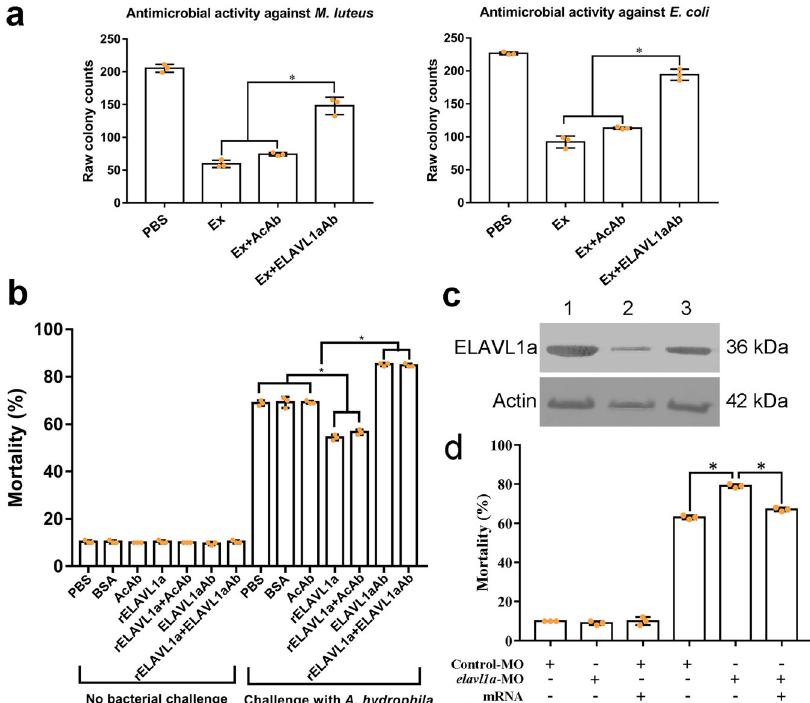
Fig. 6 Antibacterial activity of ELAVL1a in vitro and in vivo. a Antimicrobial activities of the embryo extract against M. luteus and E. coli . b The early (8-cell stage) embryos were fi rst microinjected with PBS, BSA, anti- β -actin antibody (AcAb), anti-ELAVL1a antibody (ELAVL1aAb), rELAVL1a, and rELAVL1a plus AcAb or rELAVL1a plus ELAVL1aAb and then challenged by injection with live A. hydrophila (8.3 × 10 7 cells/ml). The development of the embryos was observed, and the cumulative mortality rate was calculated at 24 h after bacterial injection. c Western blotting analysis of the ef fi cacy of elavl1a -MO. β - Actin was used as control. Lane 1, 2, 3, the levels of ELAVL1a and β -Actin in the embryos injected with control morpholino (1), elavl1a -MO (2), or co- injection of elavl1a -MO plus elavl1a -mRNA (3). d The reduced antibacterial activity of the elavl1a -MO-knockdown embryos. The 24-h mortality of elavl1a - MO-knockdown group, control group, and rescued group, after the challenge with live A. hydrophila (8.3 × 10 7 cells/ml). All data were expressed as mean values ± S.D. ( n = 3). The data are from three independent experiments performed in triplicate. The bars represent the mean ± SD. The signi fi cance of the difference was determined by one-way ANOVA. * p < 0.05. M, marker; con, control; Ex, embryo extract; AcAb, anti- β -actin antibody; ELAVL1aAb, mouse anti-ELAVL1a